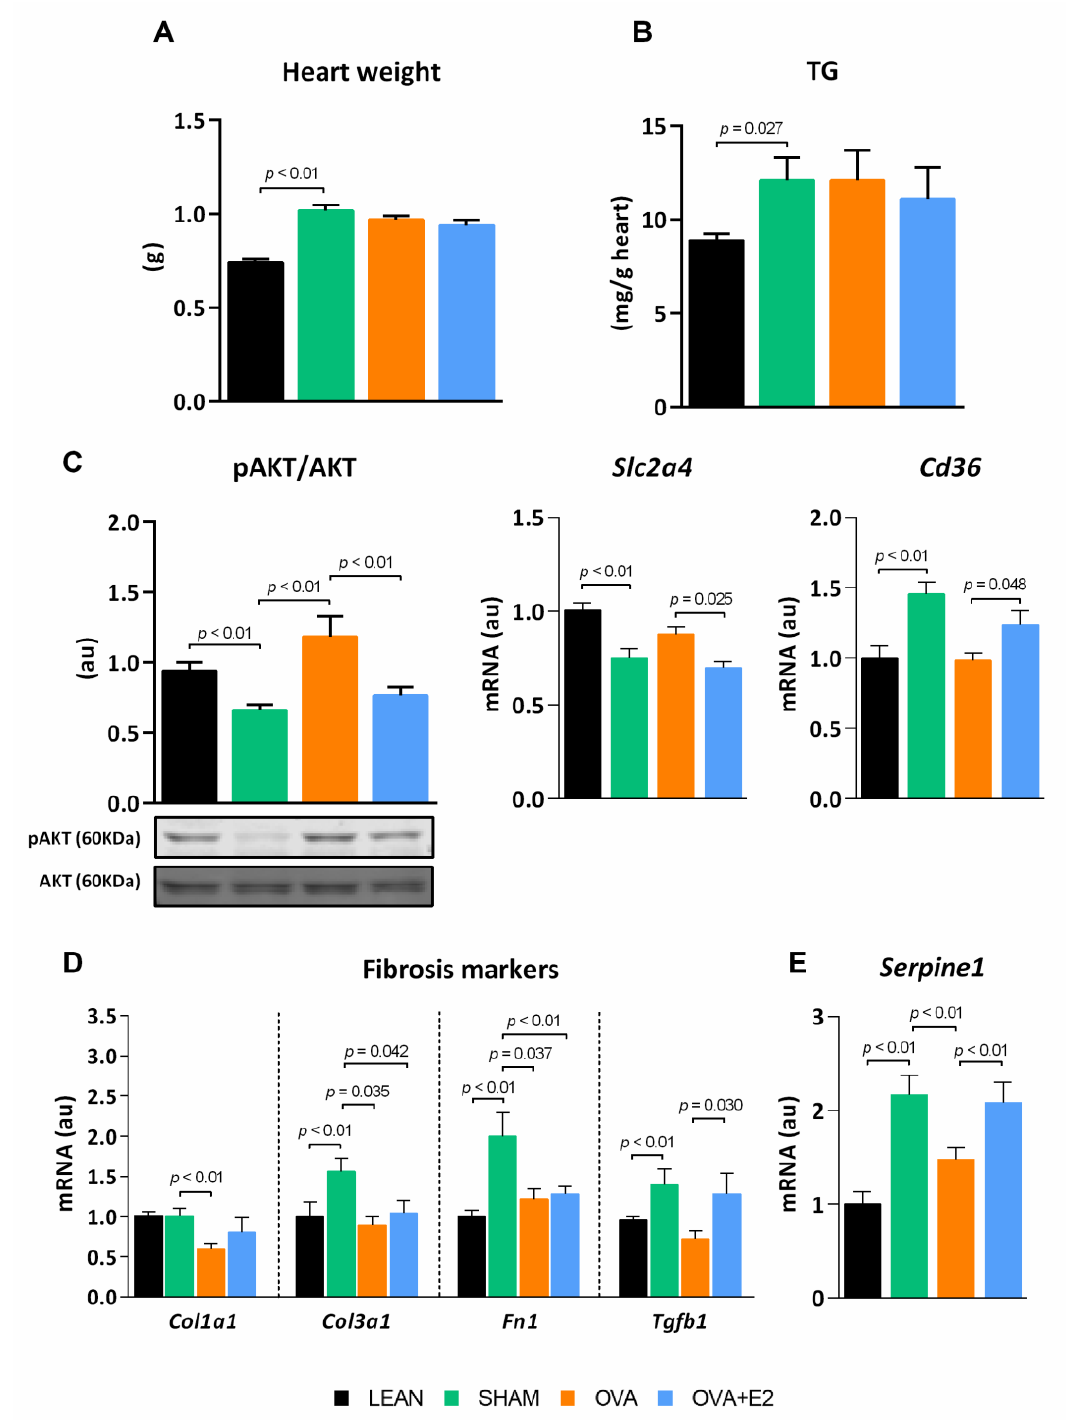
Figure 7. Ovariectomy and E2 treatment effects on cardiac fat content, metabolic and fibrosis markers. ( A ) Heart weight and ( B ) TG content. ( C ) Insulin pathway and expression of Cd36 . mRNA expression of ( D ) fibrosis markers and ( E ) Serpine1 . Fn1 , fibronectin 1; Tgfb1 , transforming growth factor beta. pAKT protein bands were normalized to total AKT protein intensity. mRNA levels were normalized to housekeeping Gapdh expression. Values are expressed as the mean ± SEM. Values in C, D and E are expressed in arbitrary units (au) related to LEAN group. Differences between obese-diabetic (SHAM) and control (LEAN) animals were analyzed by Student’s t -test. Differences between obese-diabetic groups with different hormonal manipulation were analyzed by One-way ANOVA with Fisher’s LSD post-hoc test.